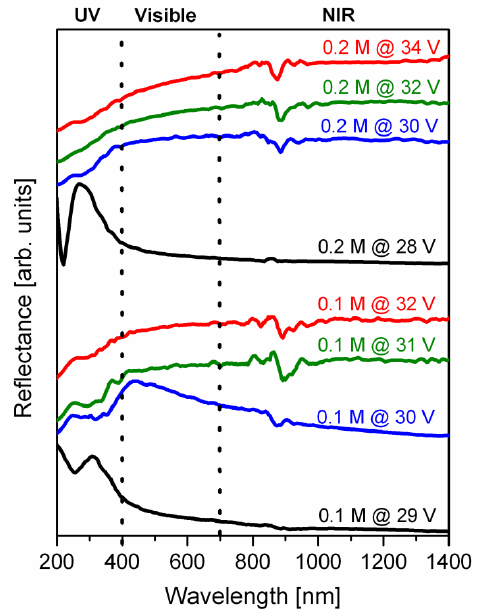
Figure 10. Reflectance spectra of PAA and b-PAA samples obtained in two series of experiments with different 0.1 M and 0.2 M sulfuric acid electrolyte concentrations.